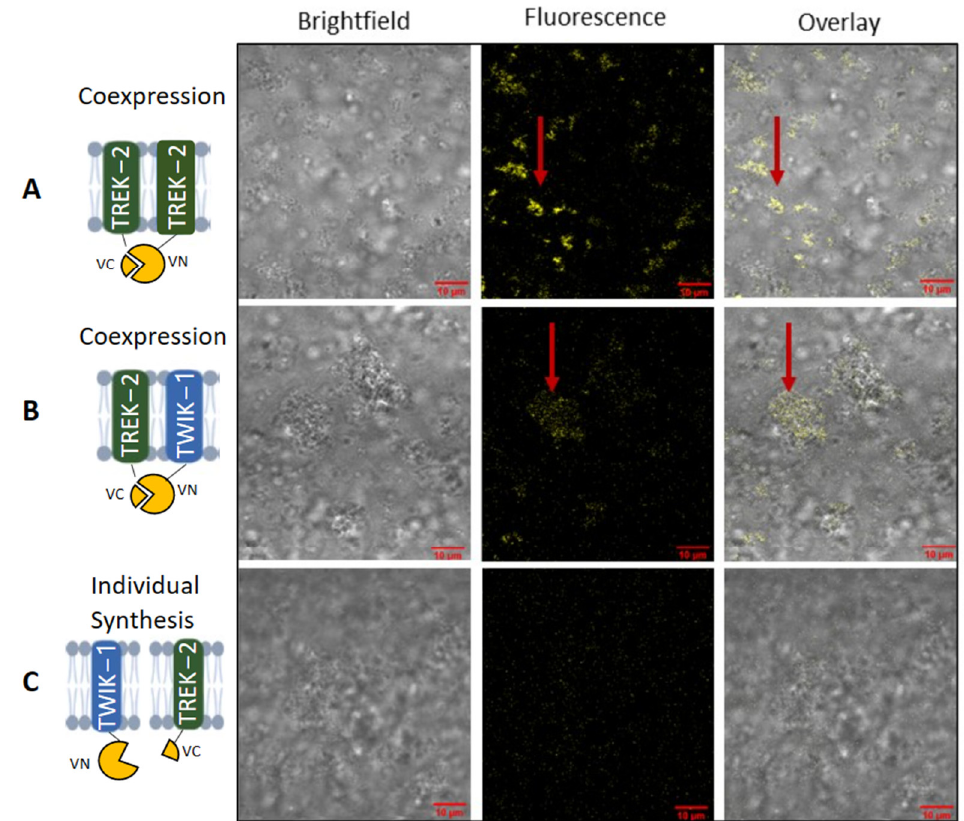
Figure 5. Heterodimerization of TWIK-1 and TREK-2. Coexpression of TREK-2 and TWIK-1 fused with venus split fragments (VN and VC) and expressed in Sf 21 lysate for a biomolecular fluores- cence assay. A detectable yellow fluorescence is produced if split fragments are complemented. Fluorescence signal was detected by confocal microscopy. ( A ) Individual synthesis of TREK-2 venus constructs as positive control. ( B ) Coexpression of TREK-2 and TWIK-1 venus constructs. ( C ) Indi- vidual synthesis of TREK-2 and TWIK-1 venus constructs with mixing post-synthesis.